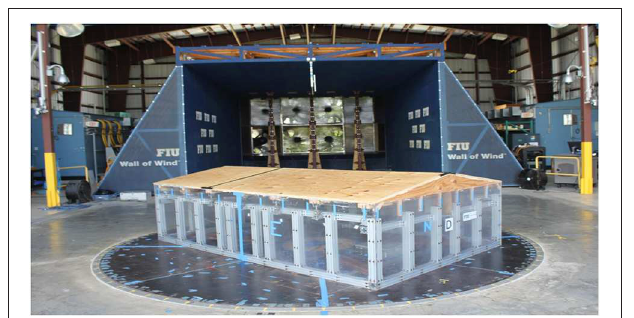
FIGURE 5 | 1:4 scale building model.